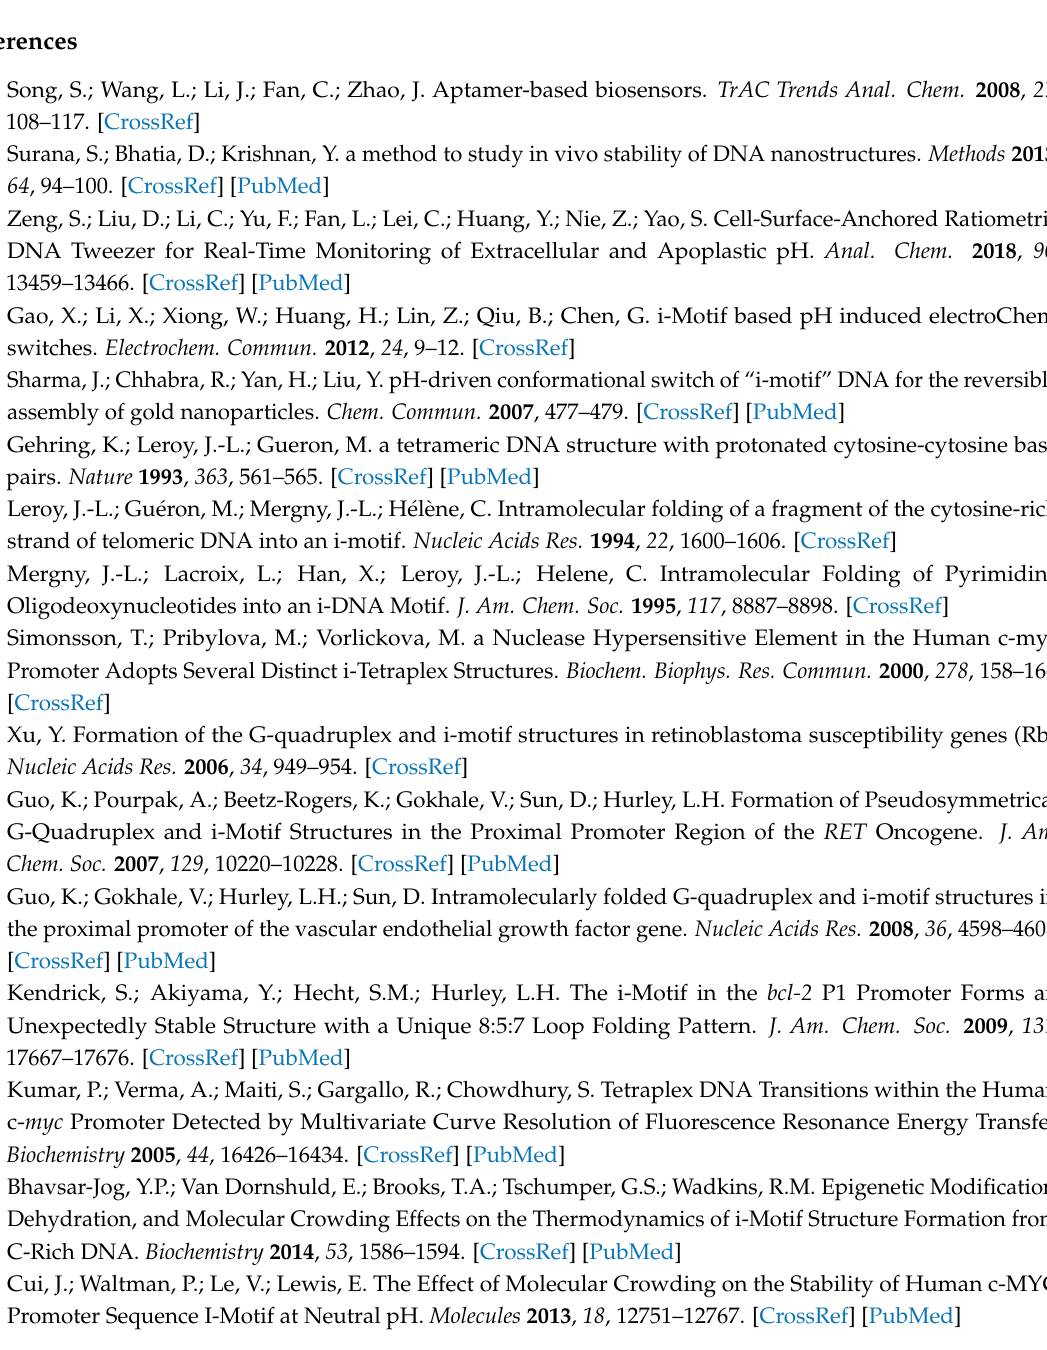
Figure S1: CD spectra of RET20 sequences in the pH range of 5.50–8.00, Figure S2: CD spectra of 8tC probe in the pH range of 5.50–8.00, Figure S3: CD spectra of 14tC probe in the pH range of 5.50–8.00, Figure S4: CD spectra of 19tC probe in the pH range of 5.50–8.00, Figure S5: The emission spectra of 14tC probe at the pH range from 5.50 to 8.00, Figure S6: The emission spectra of 17tC probe at the pH range from 5.50 to 8.00, Figure S7: The emission spectra of 19tC probe at the pH range from 5.50 to